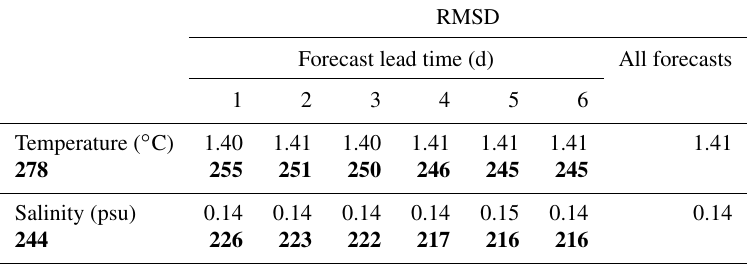
Table 6. Summary of temperature and salinity RMSD statistics between coupled ocean forecasts and in situ (Argo profile and XBT) obser- vations from 1 October to 5 November 2019. Daily averaged temperature from the model and instantaneous temperature or salinity from observations are used for the analysis. Numbers in bold indicate the number of profiles analysed for each variable and lead forecast time.